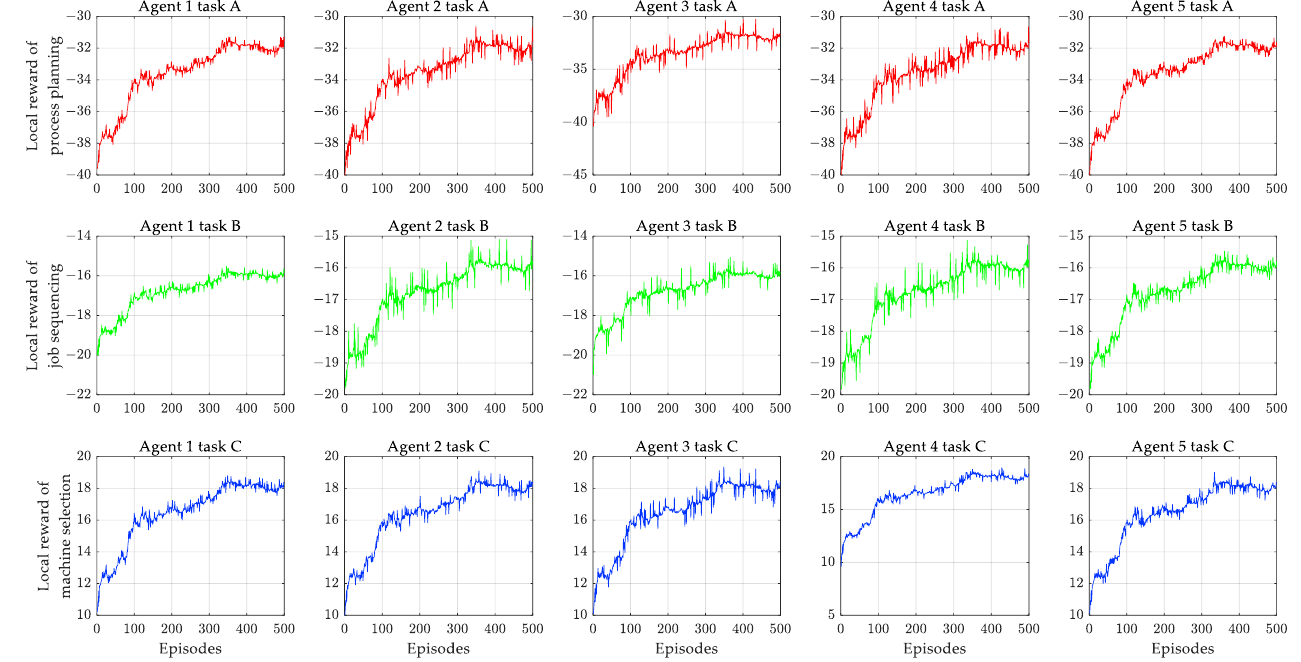
Figure 11. Convergence curve of local reward for each task of FJSP-DP (MK10).